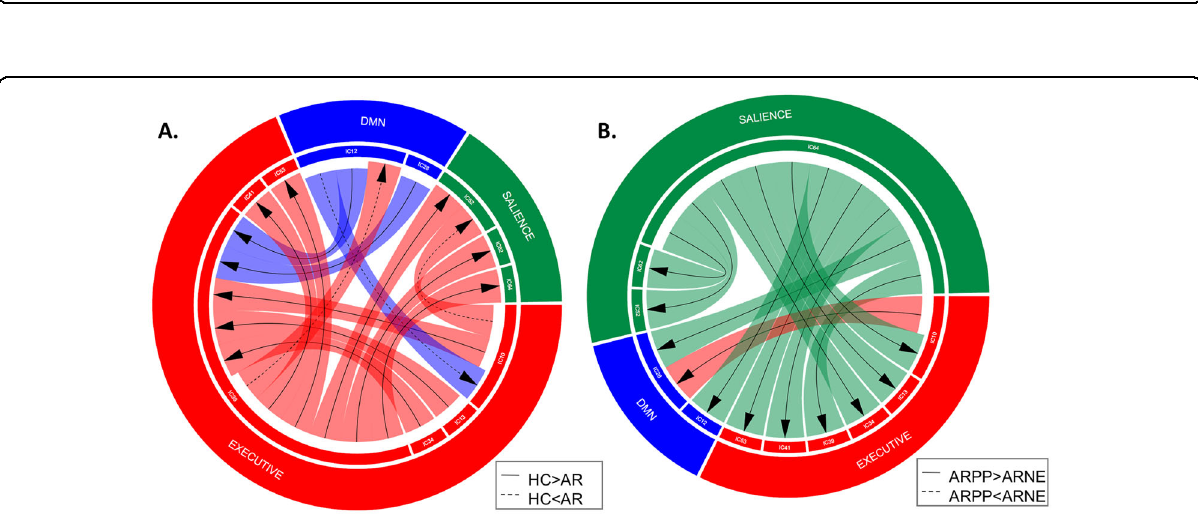
Fig. 5 Emotional load-dependent inter-network connectivity differences across diagnosis. A Fear load-dependent inter-network connectivity differences between women at risk for postpartum psychosis (AR) and control women (HCs). B Fear load-dependent connectivity differences between at risk women who developed (AR-unwell) or did not develop (AR-well) a relapse in the postpartum. Solid lines indicate signi fi cant reduced emotional load inter-network connectivity modulation in AR relative to HCs ( A ), and in AR-well relative to AR-unwell ( B ); dotted lines represent increased emotional load inter-network connectivity modulation in AR relative to HCs ( A ), in AR-well relative to AR-unwell ( B ), respectively. Arrows represent the directions of inter-network connectivity. The colours of the bands surrounding the arrows indicate the source of the connectivity. The inner circle indicates the names of the independent components (ICs). The outer circle reports the networks the ICs belong. Executive network is showed in red, salience in green, and default mode network in